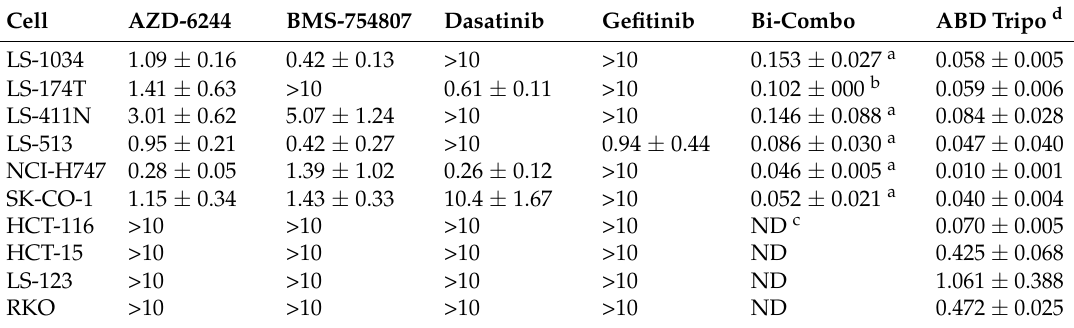
Table 3. IC 50 of signaling small molecule drugs inhibiting the proliferation of CRC cell lines.